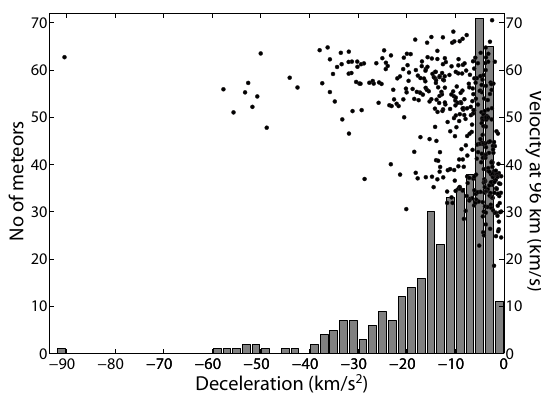
Fig. 7. Distribution of observed deceleration and a scatter plot of the velocity versus